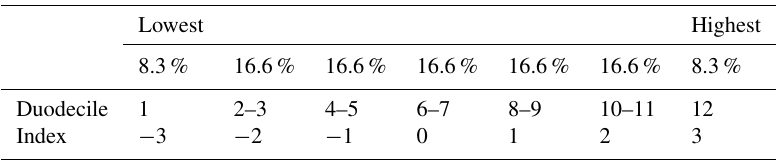
Table 2. The definition of the weighted temperature and precipitation index values used in the creation of initial (pre-1999) seven-point “Pfister” indices (after Pfister, 1992).